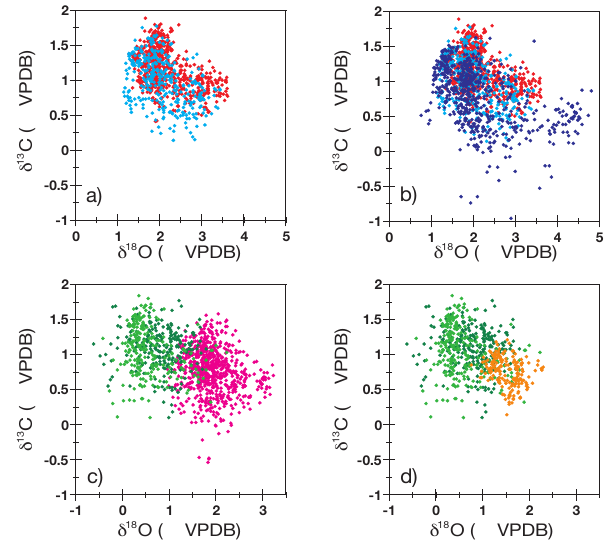
Fig. 10. δ 18 O versus δ 13 C scatter plots of the records shown in Fig. 7. (a) IODP Site U1313 (red) and MD01-2446 (light blue); (b) IODP Site U1313 (red), MD01-2446 (light blue), and ODP Site 980 (dark blue); (c) MD03-2699 (magenta) and ODP Sites 1056 (dark green) and 1058 (light green); (d) ODP Sites 1056 (dark green) and 1058 (light green) and MD01-2443 (orange; de Abreu et al. (2005); with extreme values between 375 and 381ka